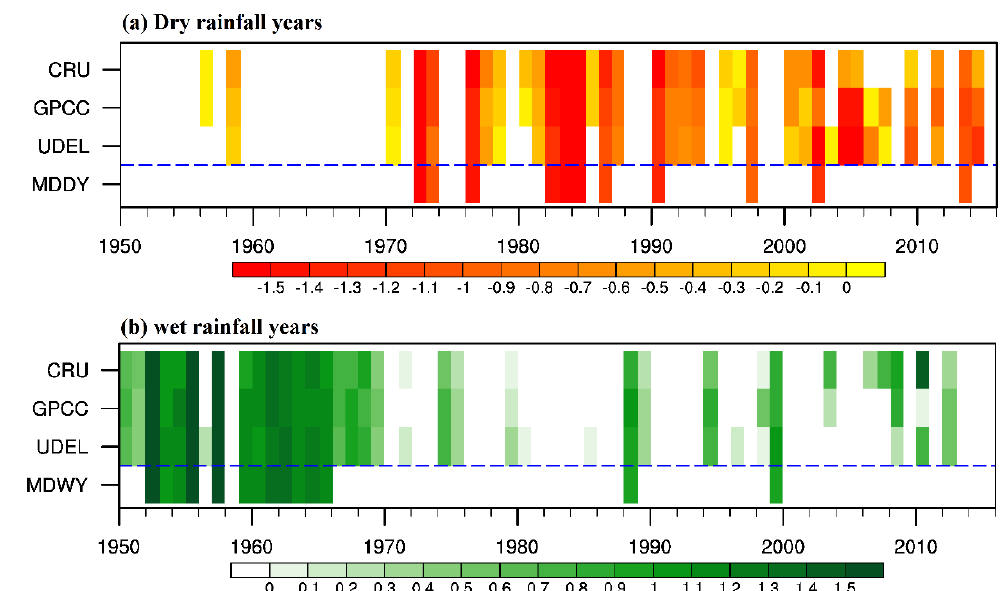
Figure 1. Standardized summer monsoon rainfall anomaly over West Africa for ( a ) dry years and ( b ) wet years. The blue line in ( a , b ) demarcates the newly developed multidata dry years (MDDY) and multiyear wet years (MDWY) from the observation’s series. Abbreviations: CRU (Climate Research Unit Time Series (TS) (CRU TS 4.01)) [36]; GPCC (Global Precipitation Climatology Centre version 7) [37]; and UDEL (University of Delaware version 3.01).